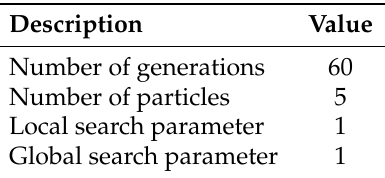
Table 5. Parameter values of PSO